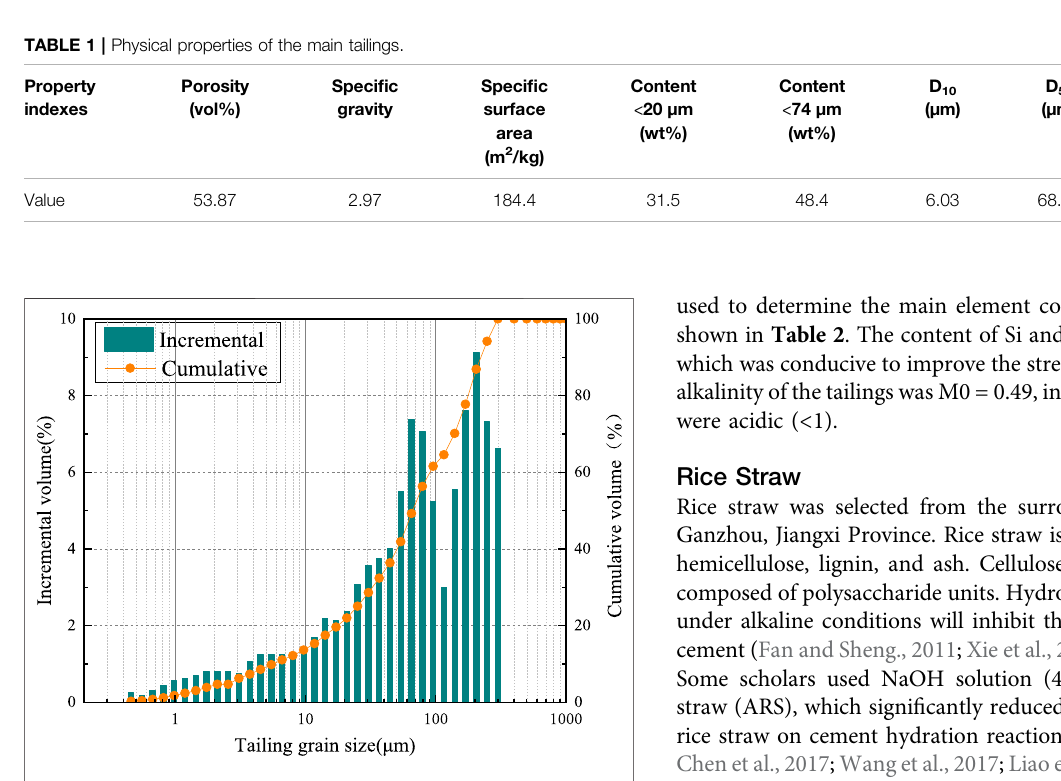
FIGURE 1 | Particle size distribution of unclassi fi ed tailings.